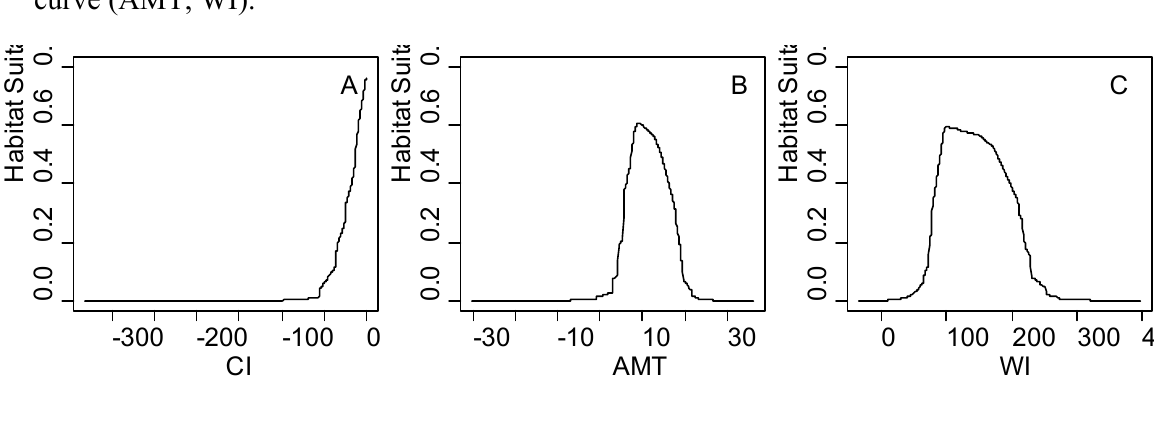
Figure 5. The response curve of climatic suitability for three dominant climatic factors based on MaxEnt model; ( A ) Coldness index (CI, °C); ( B ) annual mean temperature (AMT, °C); ( C ) warmth index (WI, °C); linear response curve (CI); unimodal response curve (AMT,